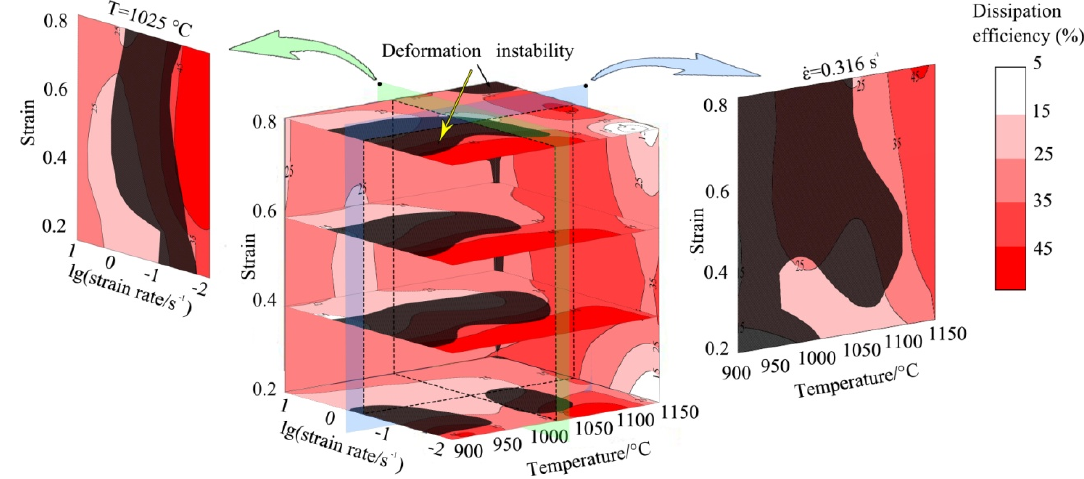
Figure 8. The three dimensional hot working maps of 300M steel.